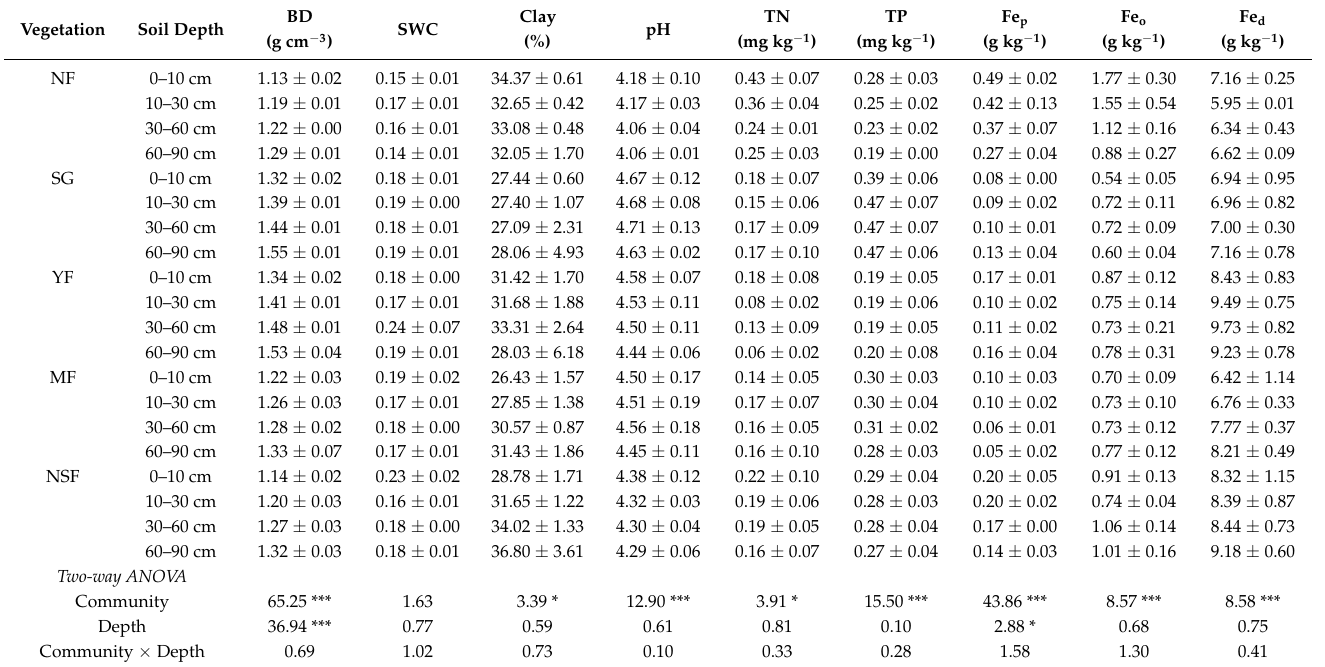
Table A2. Basic soil physicochemical properties and results of two-way ANOVA of single and interactions effects of soil depth and vegetation type on soil properties.